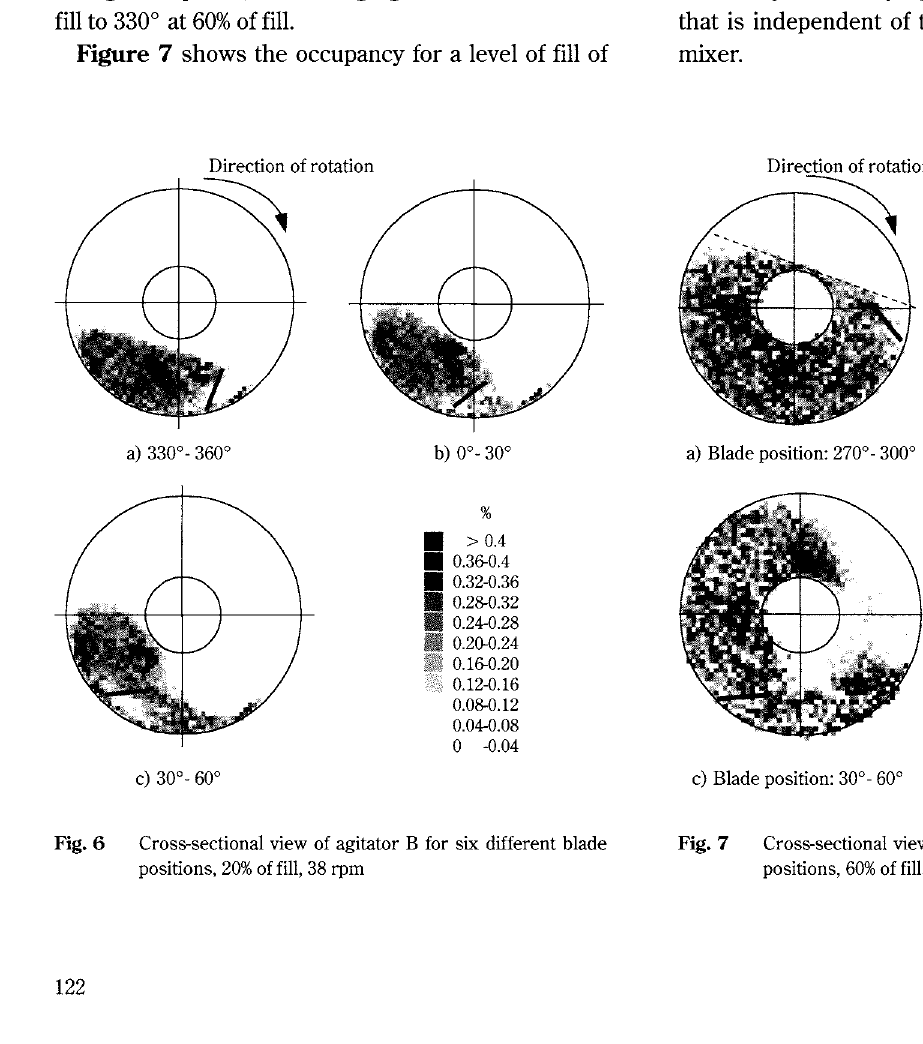
Cross-sectional view of agitator B for six different blade positions, 60% of fill, 38